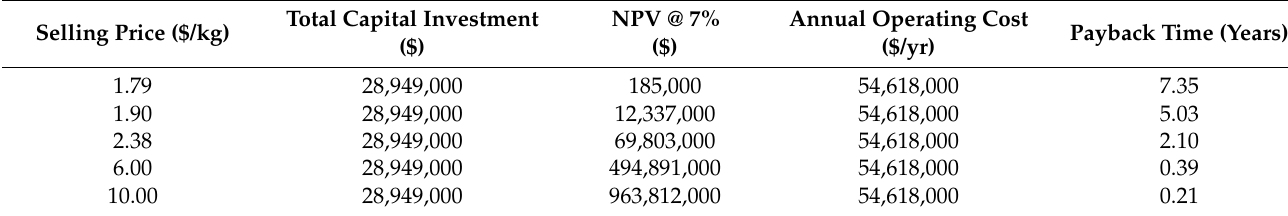
Table 12. The effect of carboxylate salt mixture selling price on process economics.